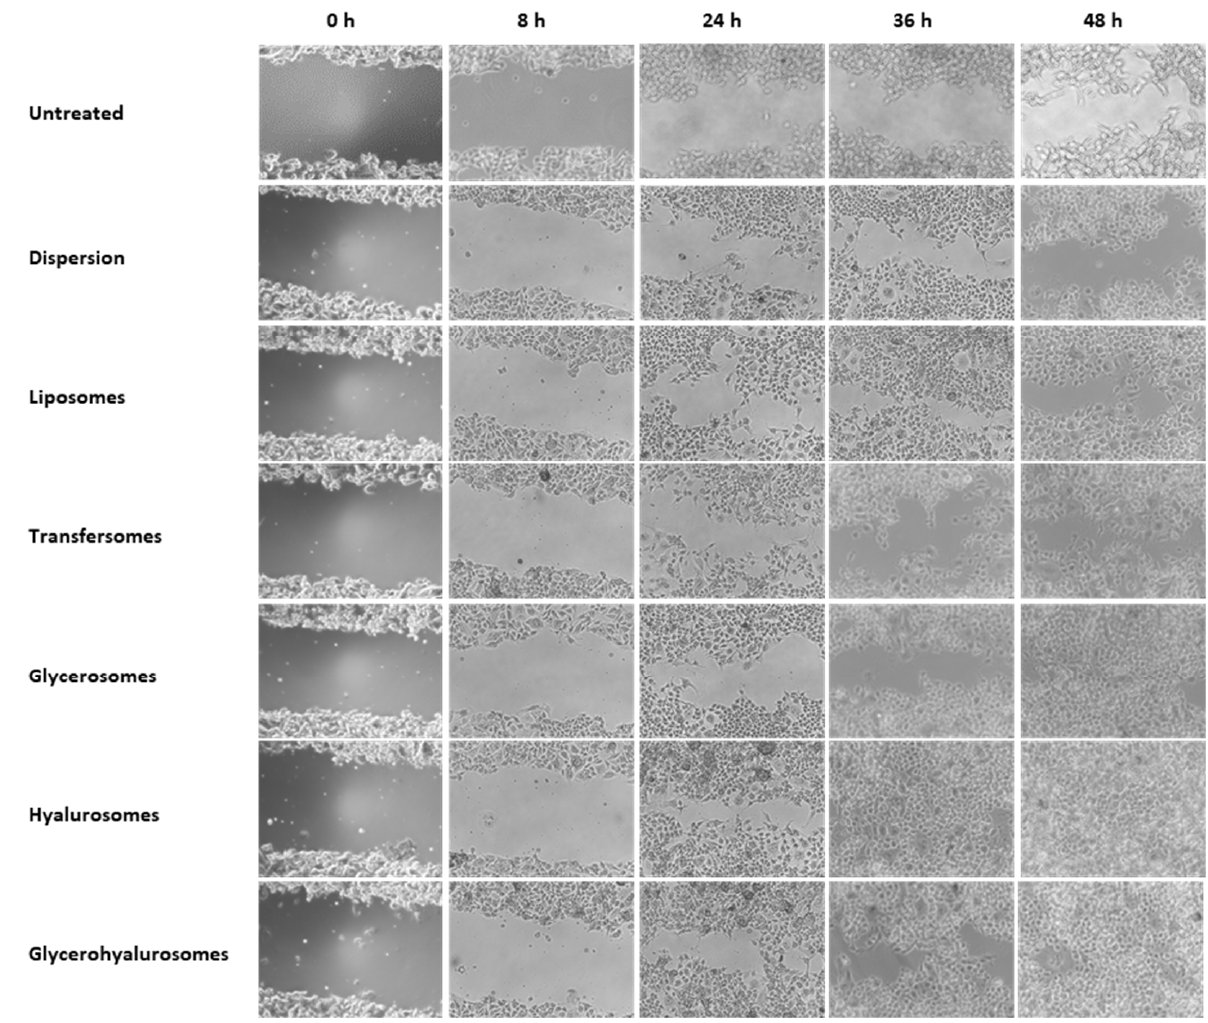
Figure 6. Representative images of the scratch performed in fibroblasts monolayers and treated with the extract in dispersion or loaded in vesicles.